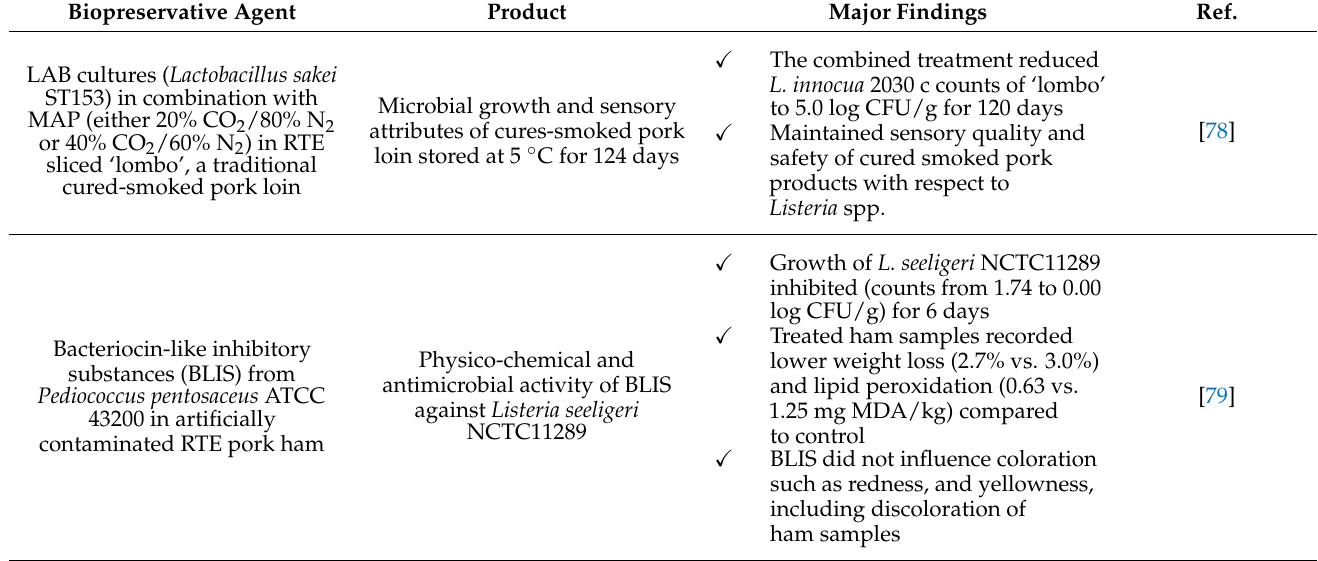
Table 2. Effect of LAB and bacteriocins on microbial, physical and sensory quality of meat and meat